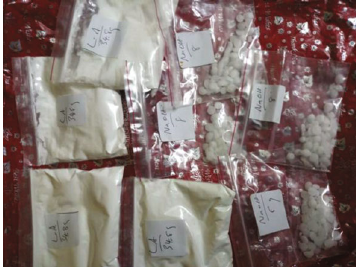
Figure 1: Amine salts.